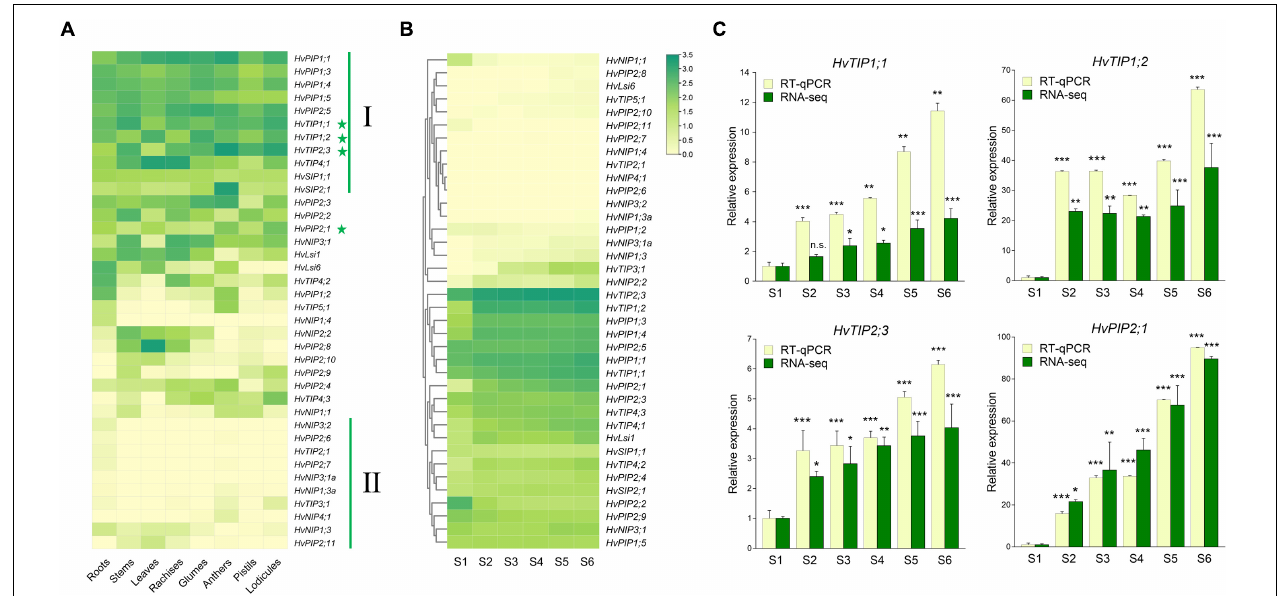
FIGURE 3 | Expression patterns of HvAQP s in different tissues and stages by RNA-seq and real-time quantitative PCR (RT-qPCR). (A) The expression levels of HvAQP s (Based on TPM values) in roots, stems, leaves, rachises, glumes, anthers, pistils, and lodicules. (B) The expression patterns of HvAQP s at six stages (S1–S6) during the glume opening and closing process. (C) The relative expression ratio of four representative HvAQP genes in S2-S6 stages with the expression in S1 as the control. Data are shown as means ± SD ( n = 3). * p < 0.01, ** p < 0.001, and *** p < 0.0001 using Dunnett’s test.